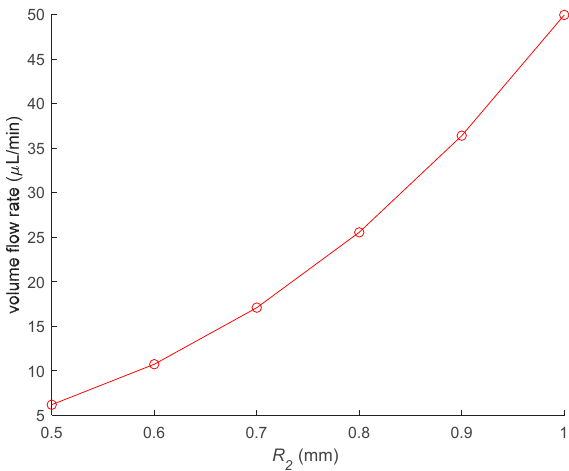
Figure 4. Theoretical volume flow rate of the micropump.